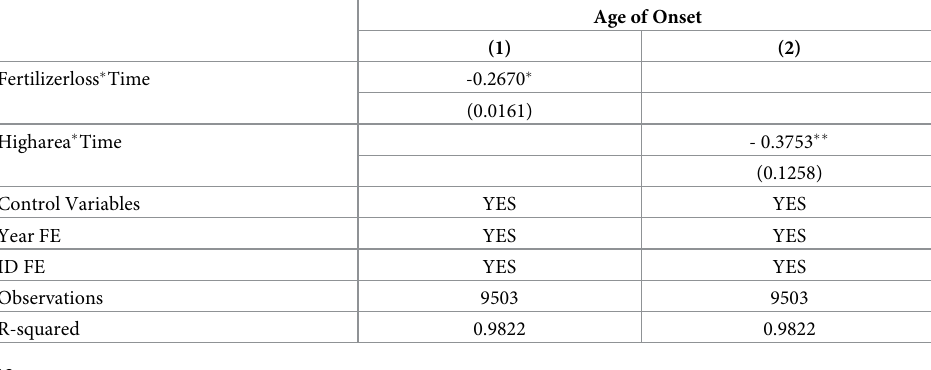
Table 4. Estimation of fertilizer loss on age of onset.